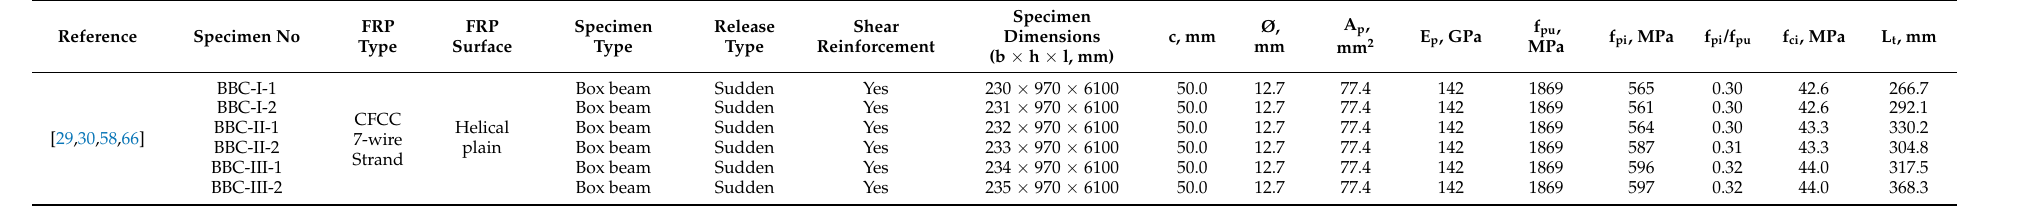
Table 2. Geometrical, mechanical properties of the material and transfer lengths of specimens with pretensioned CFCC